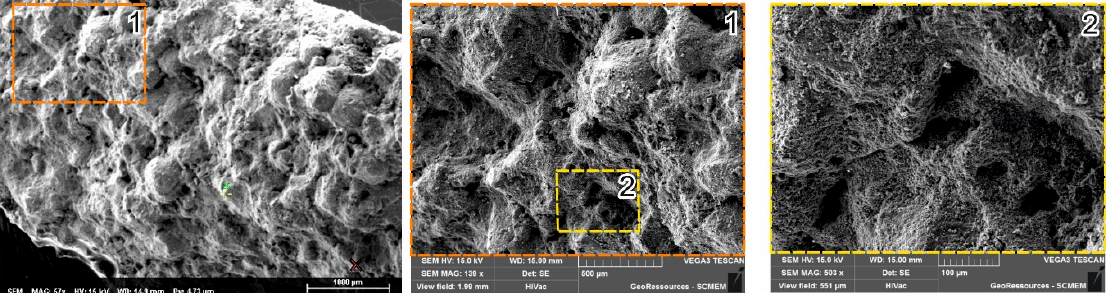
Figure 14. Multiscale Scanned Electronic Microscope (SEM) details of conical slickolites within the wall of the R 2 shear within the studied sample (experiment #7).